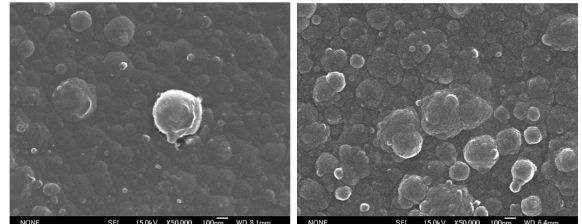
Fig. 4. Comparison of SEM images between original HBC foil and J-HBC foil. (left: original-HBC, right: J-HBC)